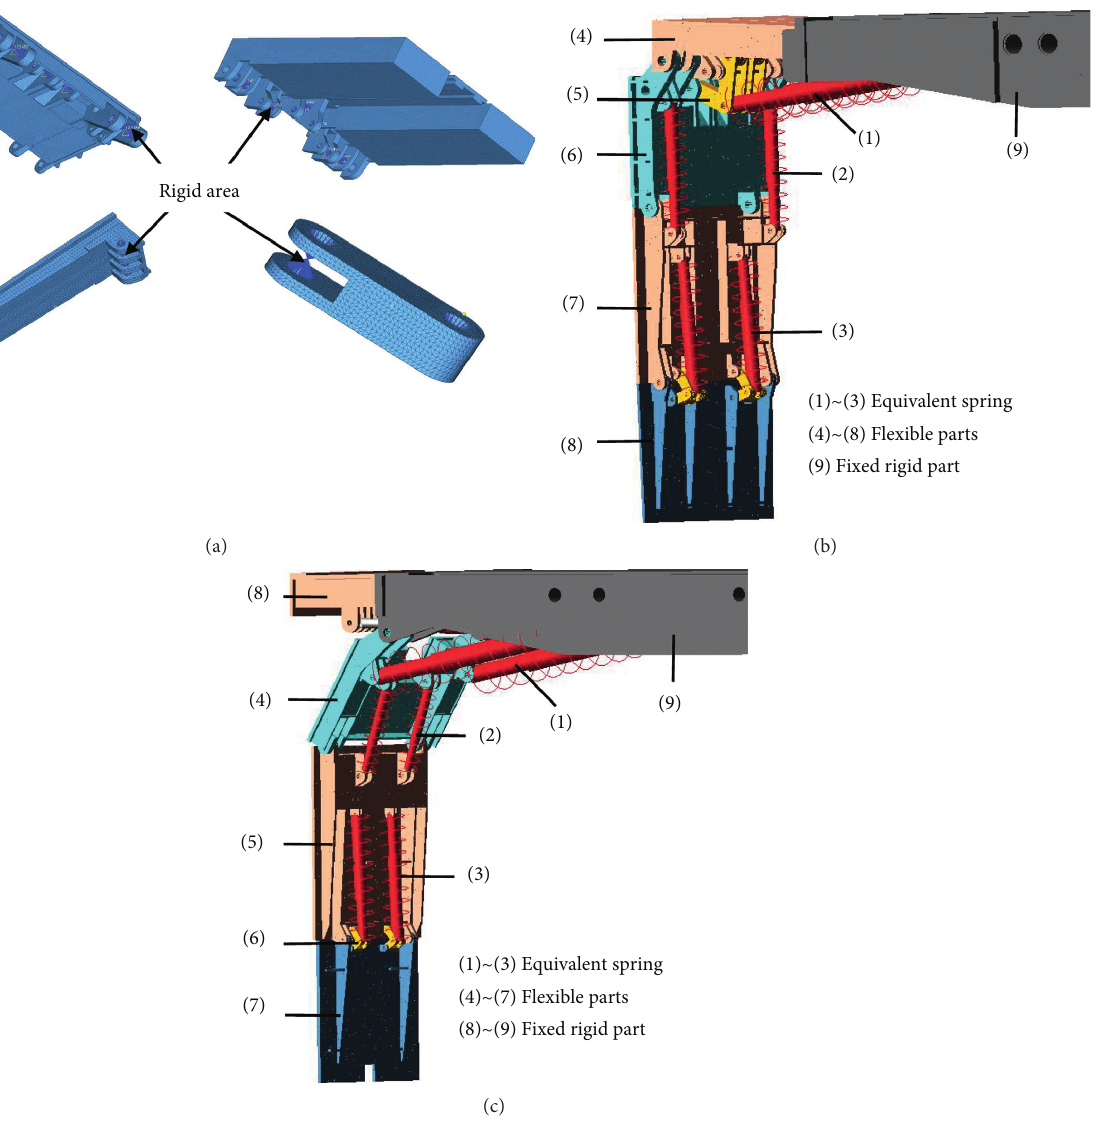
Figure 11: Numerical analysis model. (a) Rigid hinge point. (b) Numerical model of the integral face guard. (c) Numerical model of the split face